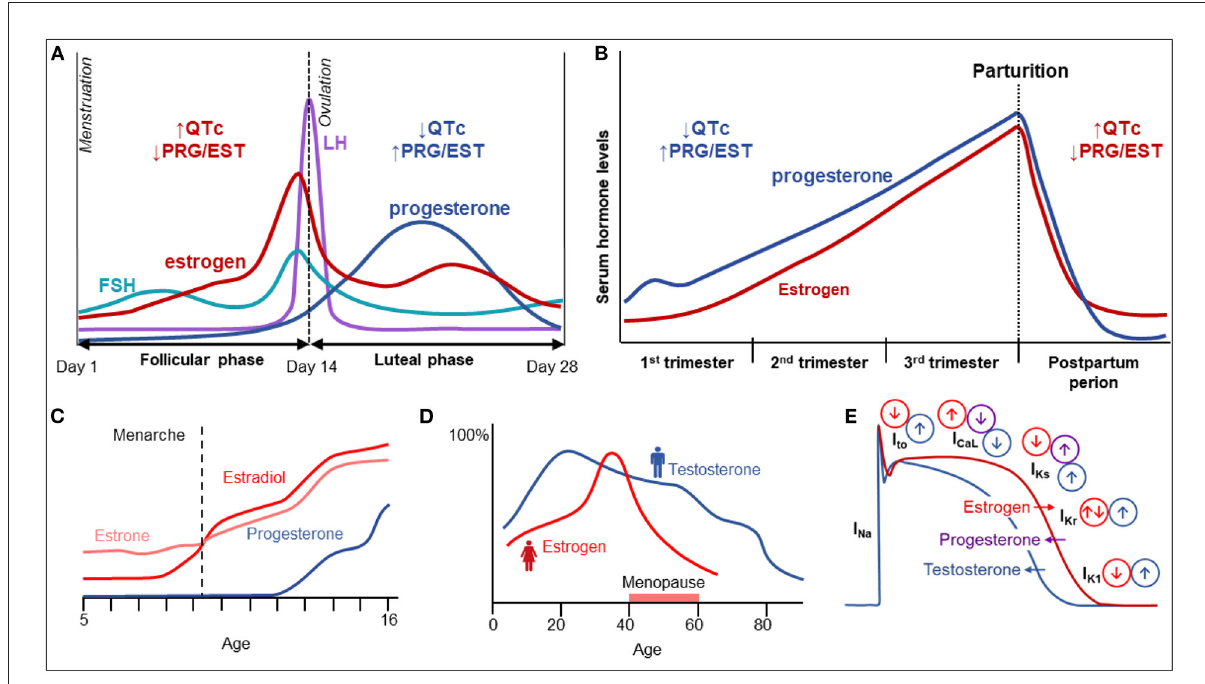
FIGURE1 Sex hormones and their influence on cardiac electrophysiology. (A) Variation in female hormone levels during the menstrual cycle. (B) Variation in female sex hormones and electrical parameters during pregnancy and the postpartum period. (C) The increase of female sex hormones until adolescence. (D) The variation of female and male sex hormones with age. (E) The influence of various hormones on cardiac electrical currents and action potential